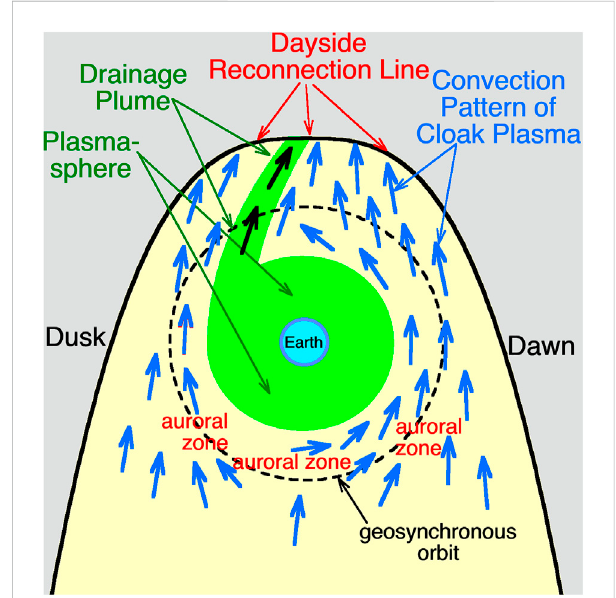
FIGURE 1 Asketchofsomeofthelow-energypopulationsintheequatorial plane of the magnetosphere during geomagnetically active times. Indicated in green is the plasmaspheric drainage plume fl owing into the dayside reconnection line and indicated in blue is the warm plasma cloak fl owing into the dayside reconnection line. Geosynchronous orbit is indicated as the dashed black